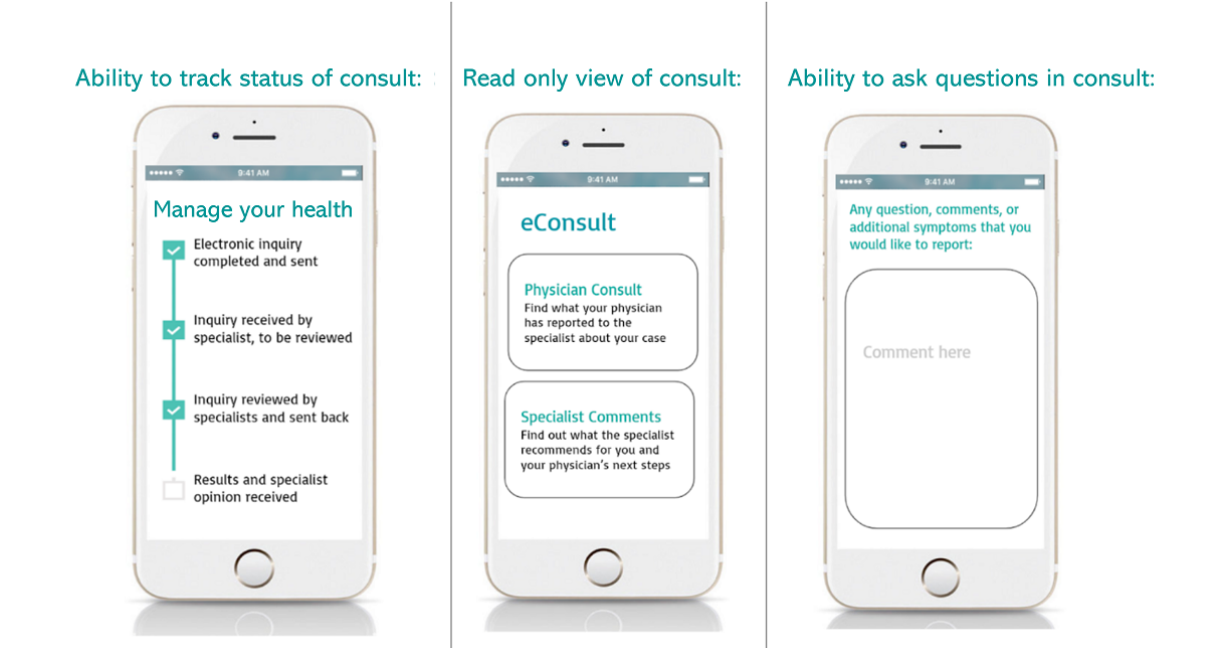
Figure 1. Prototype options for family engagement with electronic consultation. Three prototype static visual images sequentially presented to interviewees during